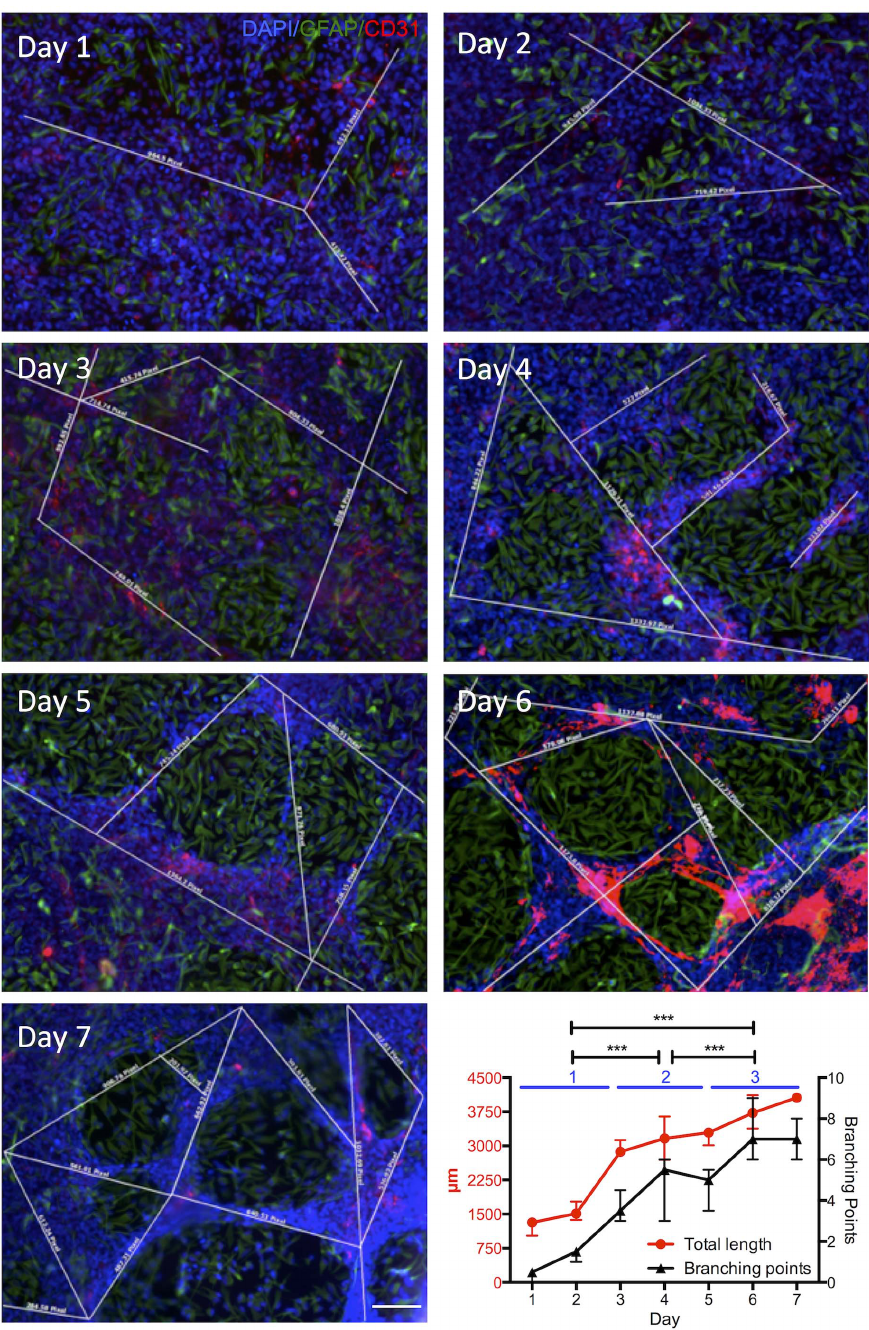
Figure 10. Time course of endothelial morphogenesis. Immunocytochemistry using antibodies against CD31 (red) and polyclonal GFAP (green) revealed vascular morphogenesis in hCMEC/hNSC coculture with different culture durations of 1 to 7 days. The efficiency of endothelial morphogenesis that produced vasculature-like structures, where hCMECs (CD31 + ) align to form rods, was assessed by measuring the length of these rods (white lines), as well as the number of branching points between these for each image. Based on these quantifications, it was evident that total length of all individual rods and the number of branching points increased over 7 days in a linear fashion. A linear regression allowed the calculation of the slope of this progression and afforded a statistical comparison between both to indicate a significant difference in slope between VLS length and branching points. Diamidino-2-phenylindole (DAPI, blue) serves as a nuclear counterstain. Scale bar, 100 m m. Data points on the graph represent the median with bars reflecting the value range.